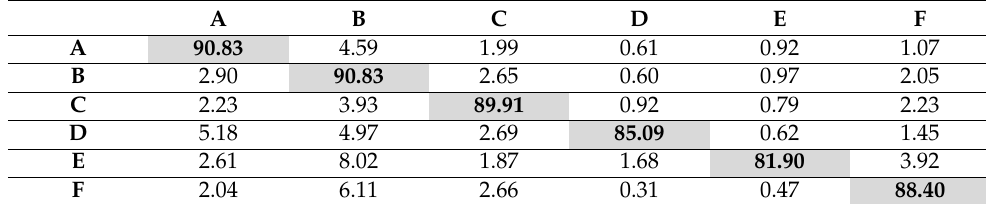
Table 5. Confusion matrix (%) of 2D-DIDGP on Set 1 using Random Forest classifier.